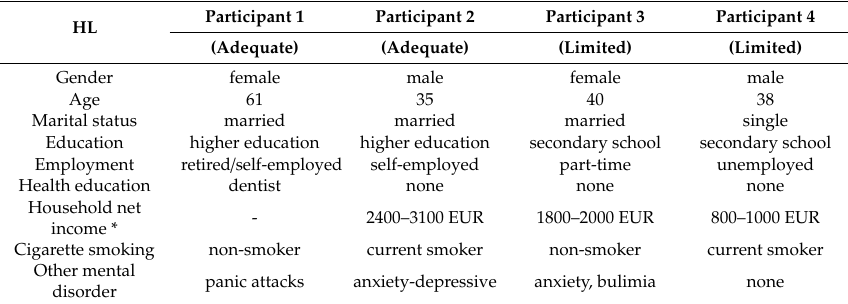
Table 1. Sociodemographic characteristics of